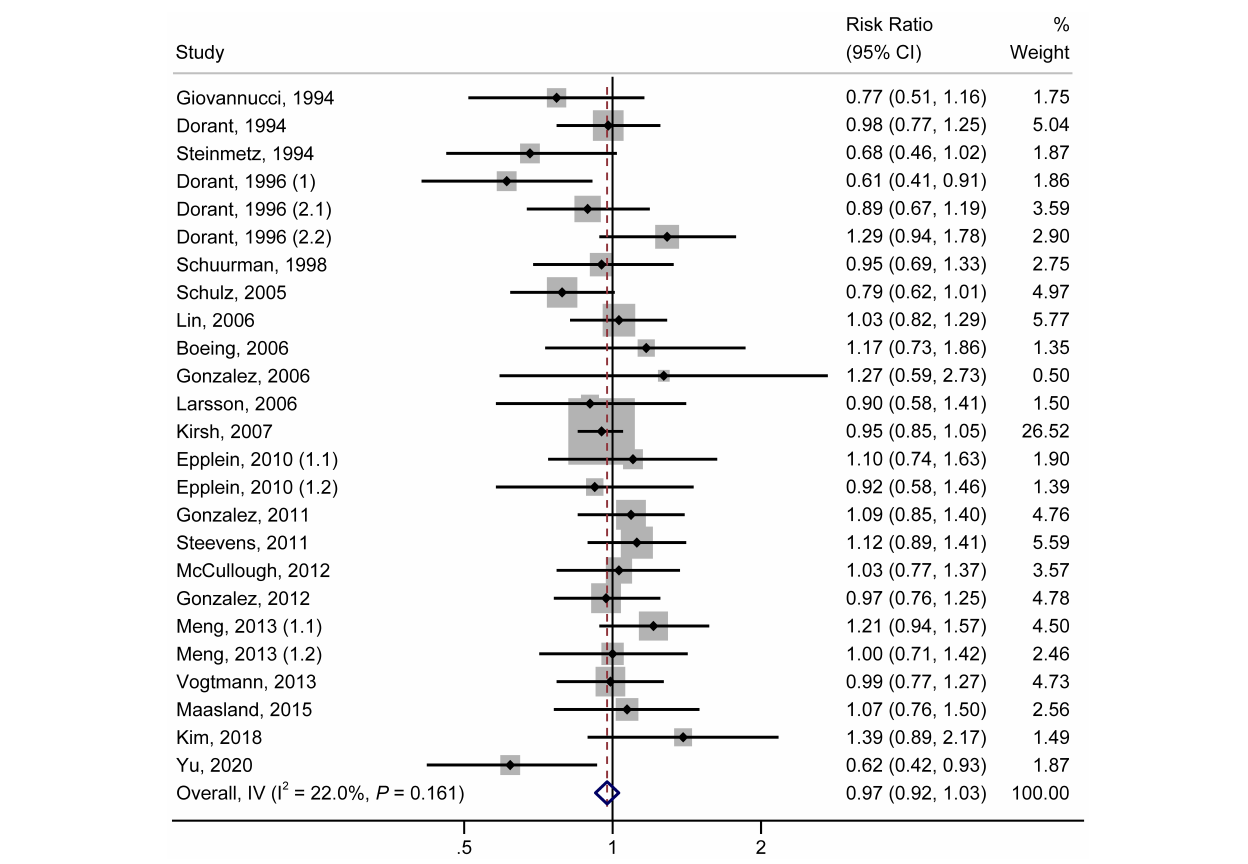
vegetable consumption and a longer duration of follow-up ( P for interaction = 0.017; Supplementary Figures 2 , 3